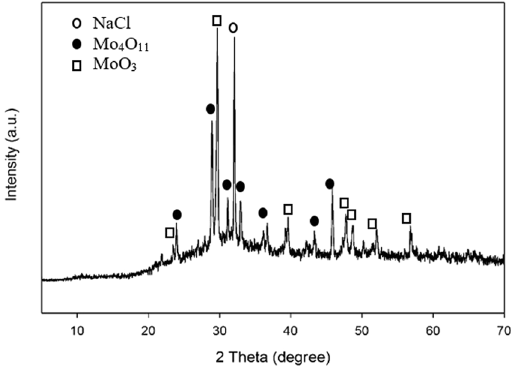
Figure 1. XRD pattern of solid precursor before the MAH